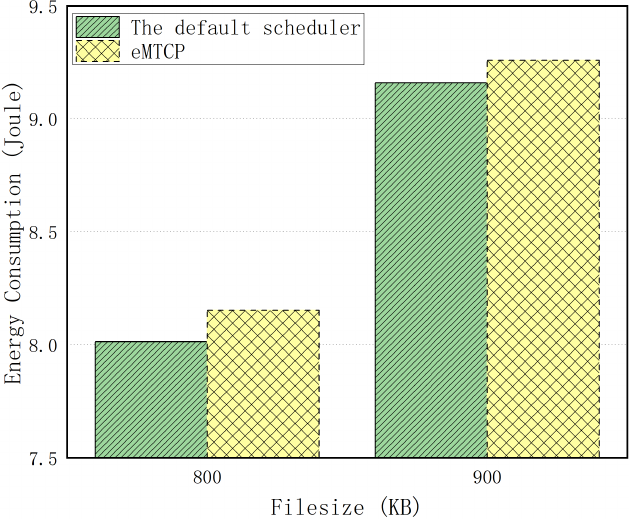
Figure 4. A close look at the energy consumption of eMTCP [13] and the default scheduler when the file size is 800 KB and 900